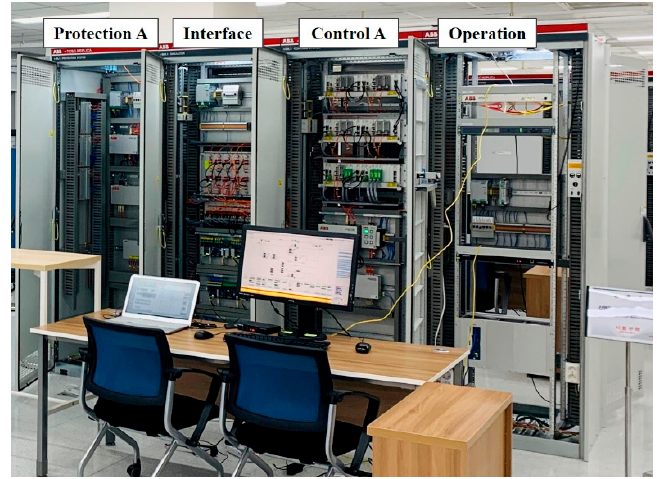
Figure 6. TCSC replica controller in Korea Electric Power Corporation (KEPCO) lab.